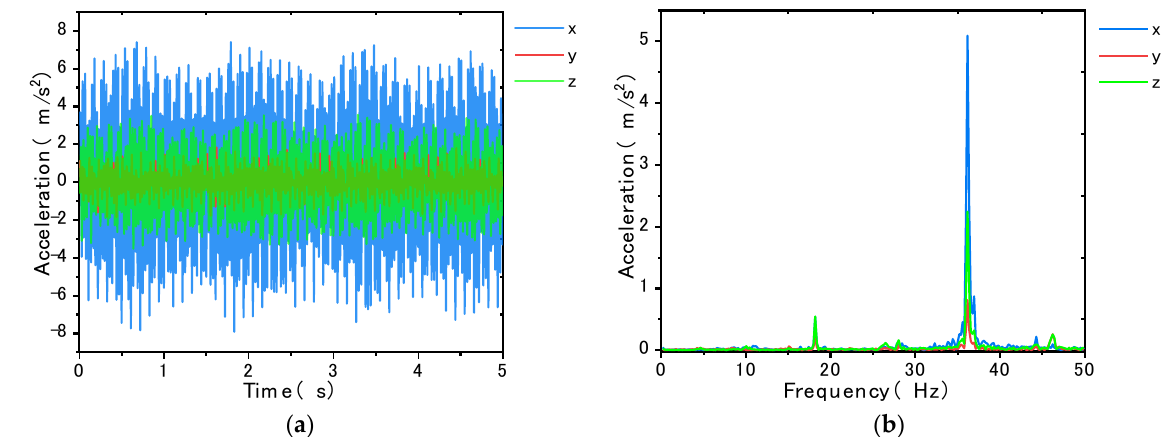
Figure 9. Results of the no-load test on the moving protection frame of the chipper tractor: ( a ) time–frequency diagram; ( b ) amplitude–frequency diagram. As shown in Figure 10a,b,c,d, the maximum amplitude of vibration in the z- direction (front and rear) of the chipper at standstill no-load is 6.6 m/s 2 , and the relative maximum amplitude is 12.8 m/s 2 in the forward and backward direction, with two peaks at 30.7 Hz and 46.7 Hz. The maximum vibration direction of the walking protection frame in the aforementioned test is in the x-direction, while the pallet is in the z- direction. The vibration amplitude in x-direction is the smallest, much smaller than the z-direction, and its value is 2.5 m/s 2 , and the relative maximum amplitude in the left and right is 3.7 m/s 2 , which is determined by the form of the components. The walking pro- tection frame is fixed by the bottom plate from the bottom z-direction, and the chipper is fixed by bolts in the x-direction of the pallet, which limits the fluctuation range to a cer- tain extent, thus the vibration amplitude is different, i.e., the vibration effect is different if the fixing method is different [35].